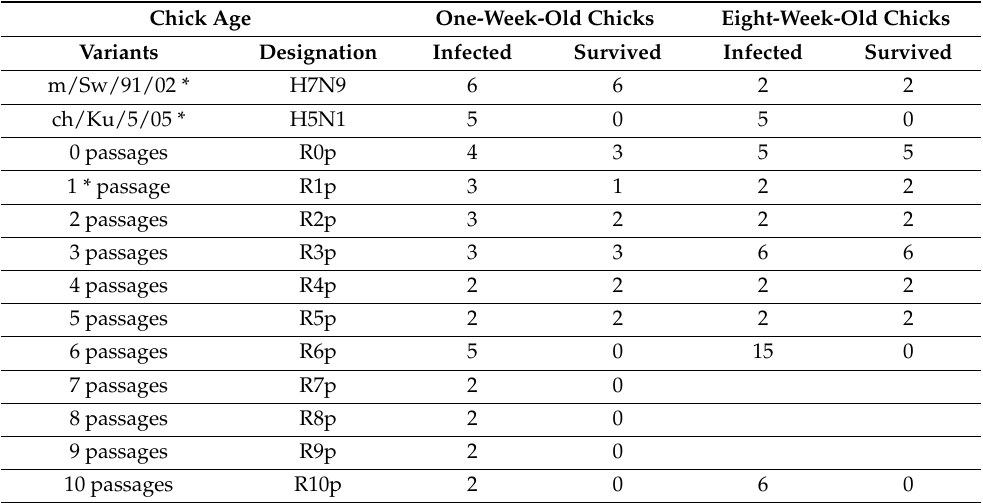
Table 2. Survival of one-week-old and eight-week-old chicks after infection with the passage vari- ants of the virus R0p.